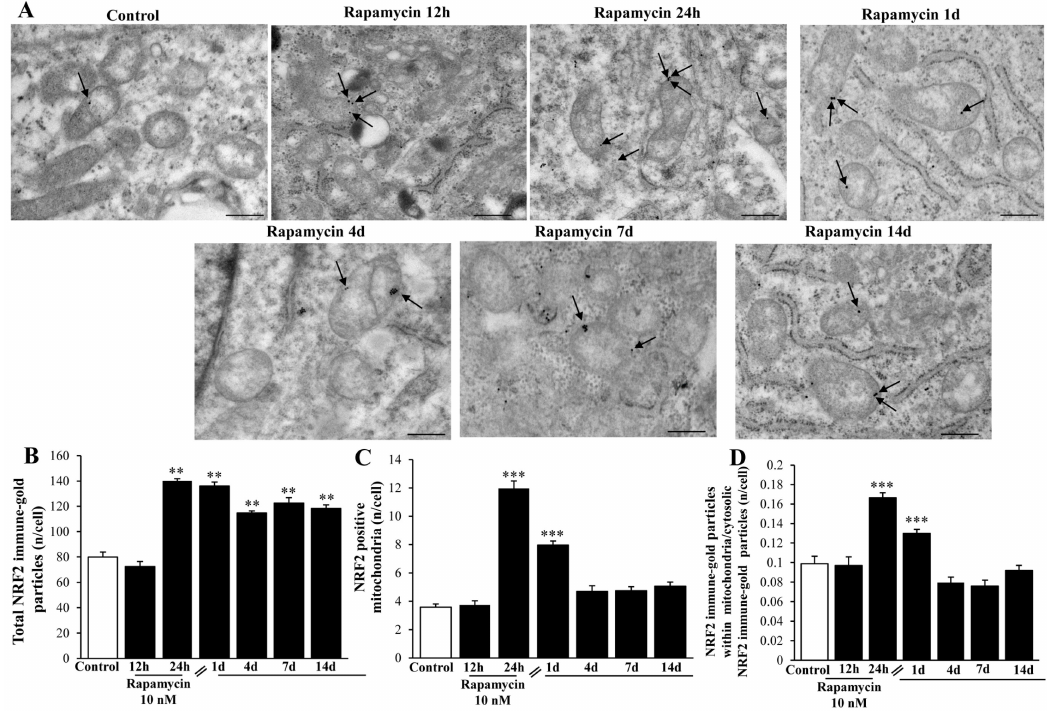
Figure 12. Rapamycin increases the amount of NRF2 immune-gold within U87MG cells. ( A ) Representative TEM micrographs showing NRF2 immune-gold particles (indicated by black arrows) within mitochondria from U87MG cells at di ff erent time intervals following rapamycin withdrawal. Graphs report the amount of NRF2 particles per cell ( B ), NRF2-positive mitochondria ( C ), and the ratio of mitochondrial / cytosolic NRF2 particles ( D ). Values were obtained from 50 cells per group. ** p ≤ 0.05 vs. Control and 12 h, *** p ≤ 0.05 vs. other groups. Scale bar = 0.8 µ